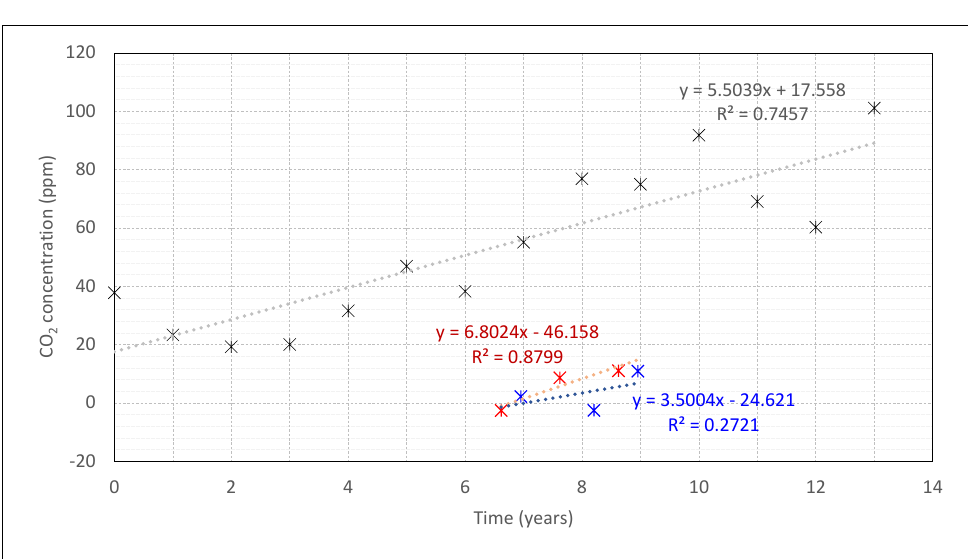
Figure 4. Offset regarding the reference sensor for all the sensors, considering periods when the building was not being used from 2008 to 2021: periods of each year in August and March 2020. From 2008 to 2016, the reference sensor is Ext (purple). Since 2014, the reference sensor is R01 Ref (green). The 0 in the x -axis corresponds to the year 2008.